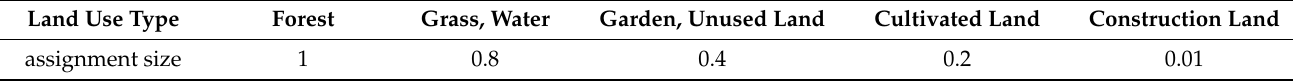
Table 2. Assignment method of the land cover